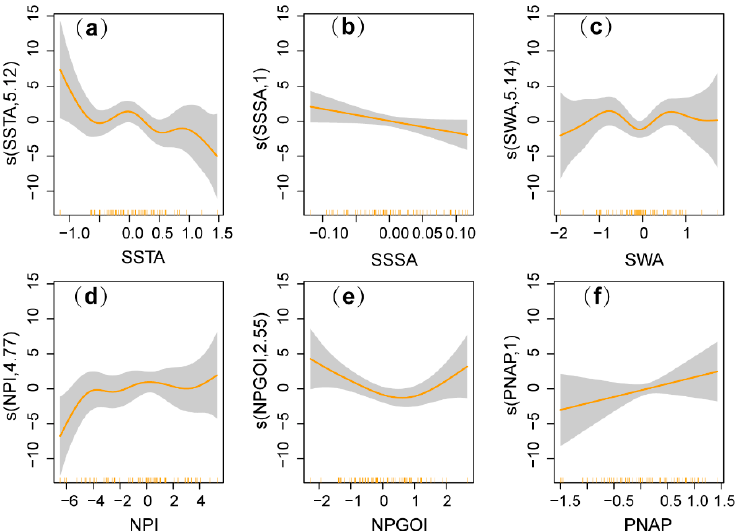
Figure 5. Generalized additive models (GAMs) between anchovy catch and environmental variables and climate indices in the California Current Ecosystem (CCE). ( a ) Anchovy versus Sea Surface Temperature anomaly (SSTA). ( b ) Anchovy versus Air Temperature anomaly (ATA). ( c ) Anchovy versus Scalar Wind anomaly (SWA). ( d ) Anchovy versus Pacific Decadal Oscillation index (PDOI). ( e ) Anchovy versus North Pacific index (NPI). ( f ) Anchovy versus North Pacific Gyre Oscillation index (NPGOI). Tick marks on the x -axis represent observed data points. Y -axis represents the smooth fitted function of the dependent values and is centered to zero. The values in parentheses in the y -axis label indicate the degree of freedom of the model.